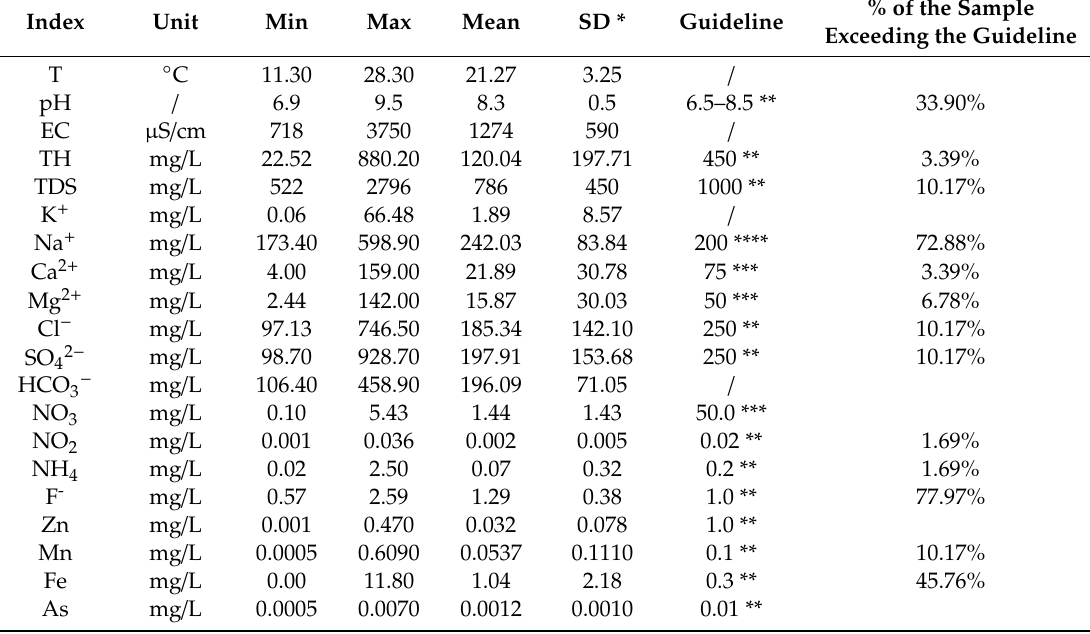
Table 3. Statistical analyses of physicochemical parameters and drinking water